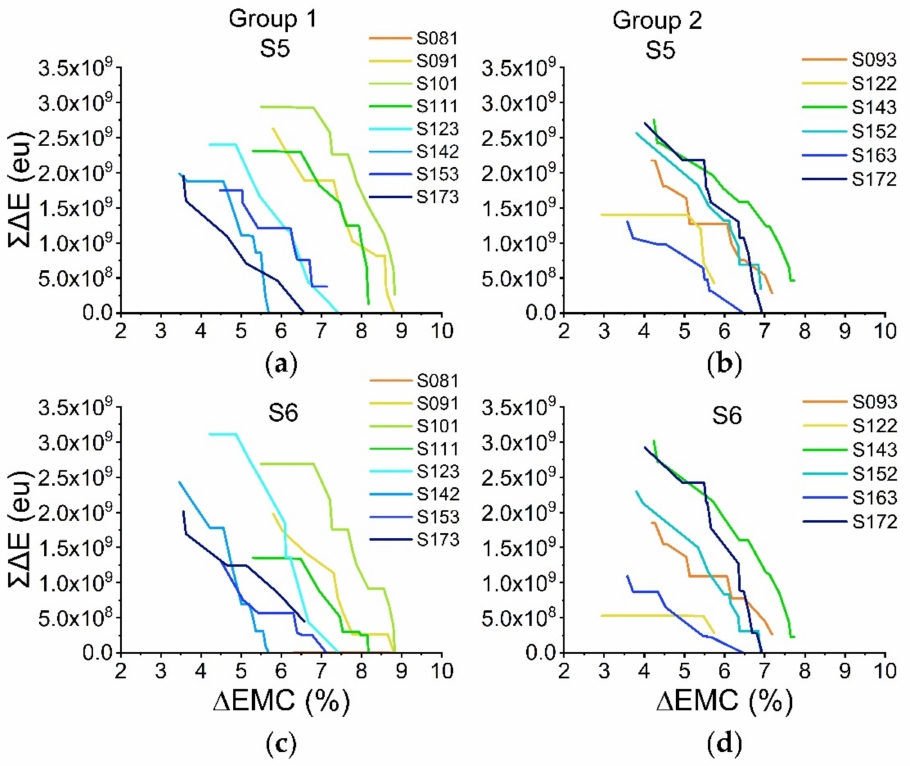
Figure 16. Σ∆ E (eu) vs. ∆ EMC (%). ( a ) Group 1, S5; ( b ) Group 2, S5; ( c ) Group 1, S6; and ( d ) Group 2, S6. Sample S081 is imperceptible from the graph due to low values of Σ∆